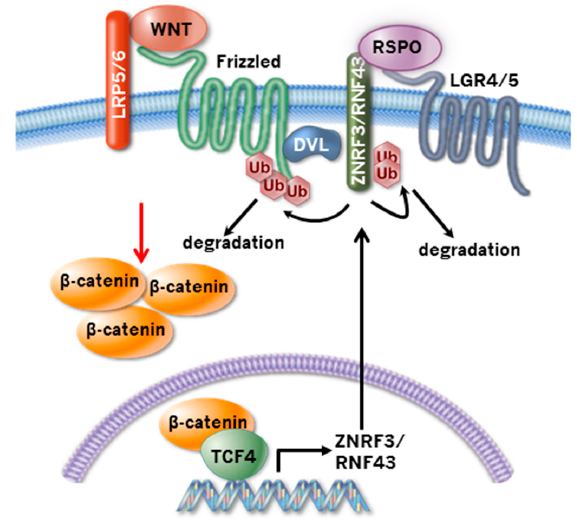
Figure 1. Feedback control of Wnt receptor turnover by R ‐ spondin ‐ ZNRF3/RNF43 signaling module.